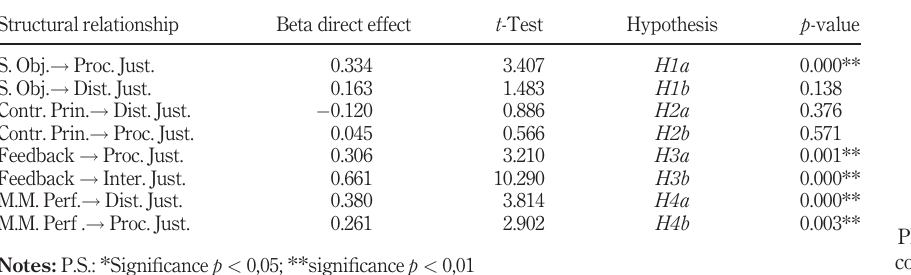
Table VI. PLS Results –